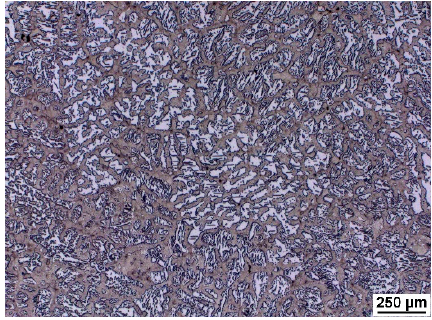
Figure 3. Casting structure of heat C.